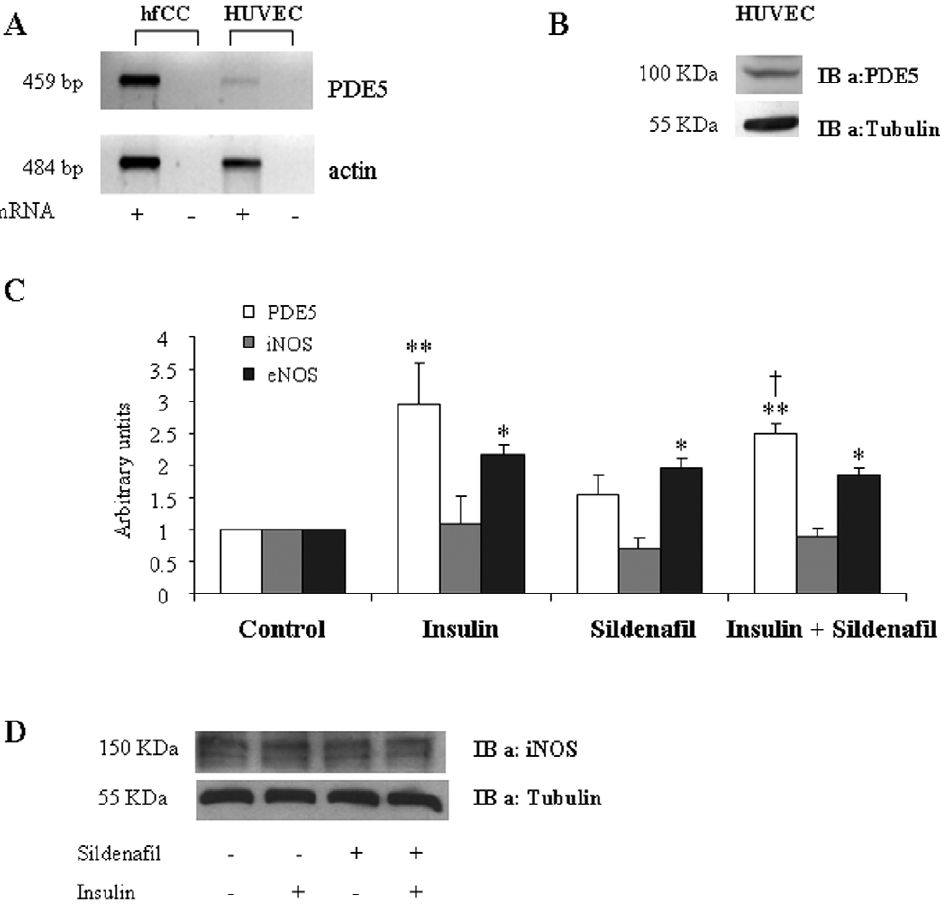
Figure 1. PDE5 and iNOS expression in human endothelial cells. A : PDE5 mRNA expression in HUVEC and hfCC cells: RT-PCR shows that HUVEC express detectable levels of PDE-5 mRNA. Actin was used as control. B : Western Blot analysis for PDE5 protein expression. C : Real time PCR shows that insulin (30 min) and/or sildenafil (5 h) treatments induce PDE5 and eNOS but not iNOS expression * p , 0.05 vs Ctrl, ** p , 0.01 vs Ctrl; { p , 0.05 vs sildenafil. D : A representative Western Blot shows that insulin (30 min) and/or sildenafil (5 h) treatments do not alter iNOS protein levels.